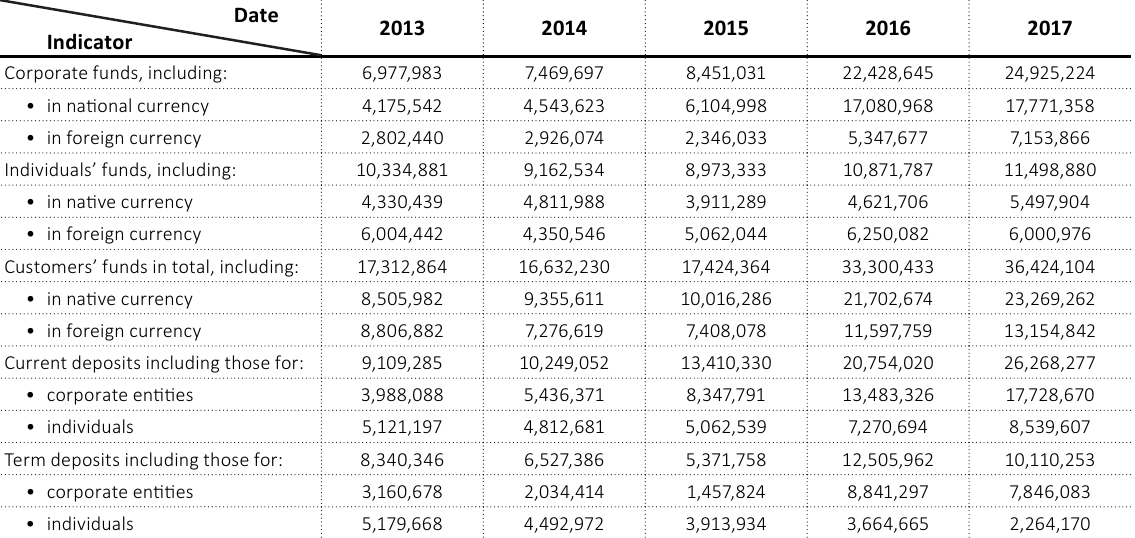
Table 2. Deposit-taking activity of Ukrsibbank for 2013–2017, UAH